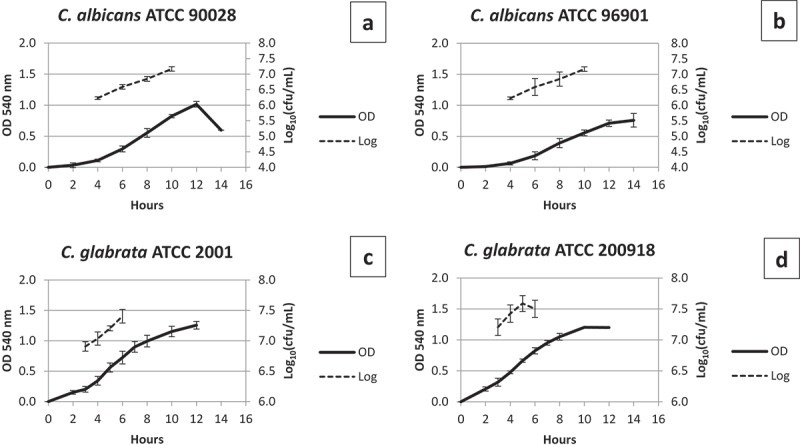
Growth curves of (A) C. albicans ATCC 90028 (CaS), (B) C. albicans ATCC 96901 (CaR), (C) C. glabrata ATCC 2001 (CgS), and (D) C. glabrata ATCC 200918 (CgR). In the mid-log phase, the mean ± standard deviation of OD540
 
nm for CaS is 0.55 ± 0.08 and the Log10 CFU/mL is 6.8 ± 0.1. For CaR, the OD540
 
nm is 0.39 ± 0.08 and the Log10 CFU/mL is 6.8 ± 0.3. For CgS, the OD540
 
nm is 0.70 ± 0.08 and the Log10 CFU/mL is 7.4 ± 0.1. For CgR, the OD540
 
nm is 0.65 ± 0.09 and the Log10 CFU/mL is 7.6 ± 0.2.